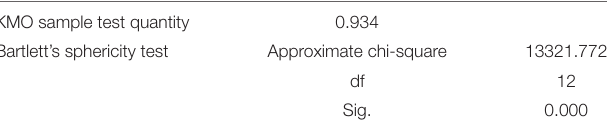
TABLE 1 | KMO and Bartlett’s sphericity